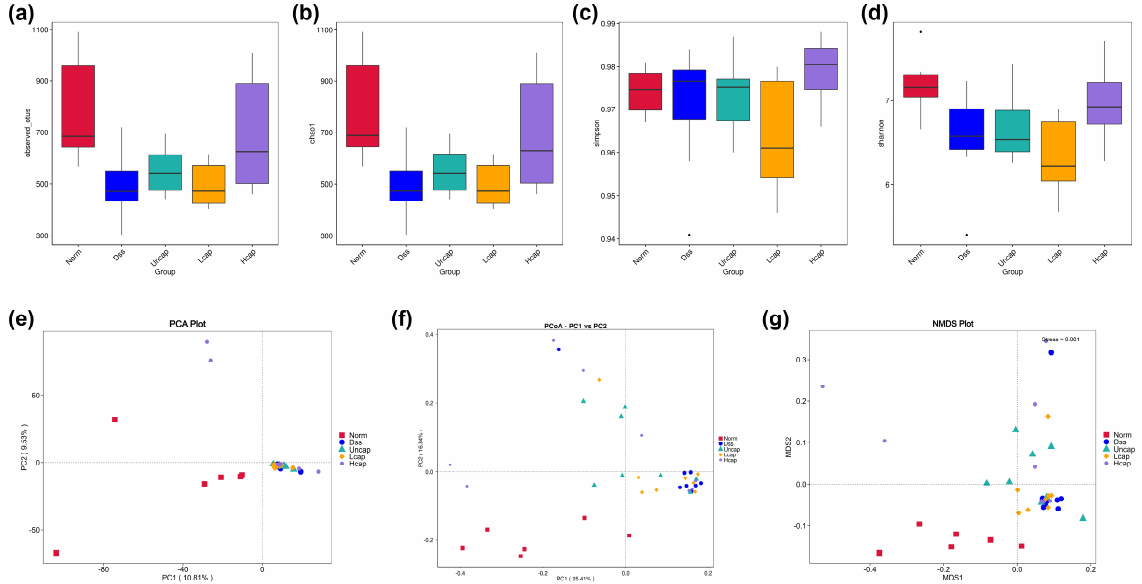
Figure 8. S. spongiosa polysaccharides remold the richness and diversity of intestinal microbiota. The alpha diversity including observed OTUs ( a ), Chao ( b ), Simpson ( c ) and Shannon ( d ) indices were measured by 16S rDNA. ( e ) PCA analysis based on ASV level. PCoA ( f ) and NMDS ( g ) analysis based on unweighted UniFrac distances.